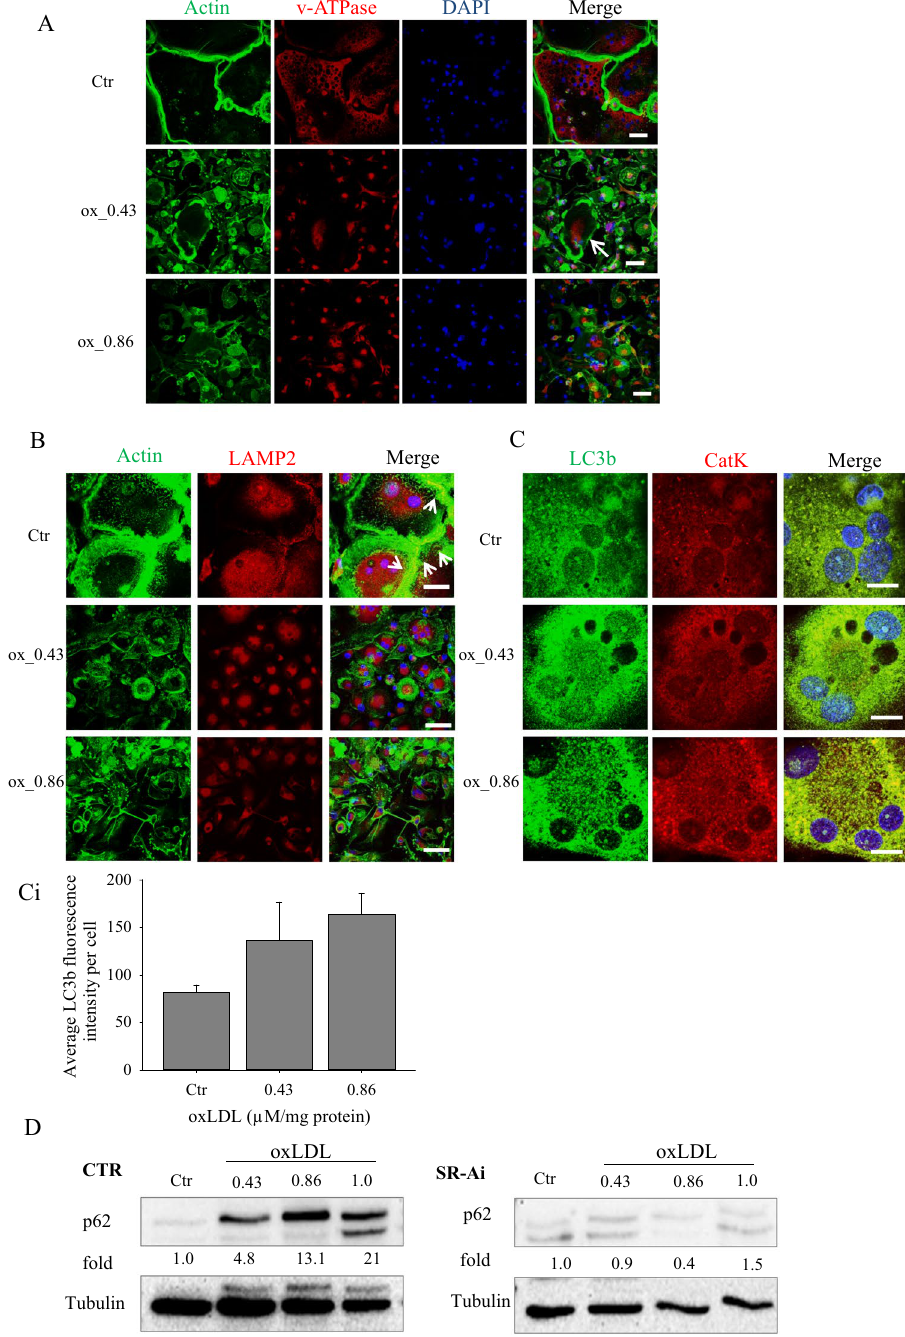
Figure 6. oxLDL inhibits targeting of lysosomal proteins to the ruffled border through autophagy regulation. ( A ) Mature osteoclasts were stained with FITC-phalloidin (green) and co-stained with v-ATPase (subunit a3) (red) Magnification x40, scale bar 50 µ m. White arrows indicate cytoplasmic localization of v-ATPase. ( B ) Mature osteoclasts were stained with FITC-phalloidin (green) and then co-stained with the lysosomal protein; LAMP2 (red) Magnification x63 scale bar 50 µ m. White arrows indicate peripheral localization of LAMP2. ( C ) Monocytes plated on glass coverslips were grown in the presence of M-CSF and RANKL for a total of 15 days. Mature osteoclasts were stained with the lysosomal marker LC3b (in green) and then co-stained with CatK (in red). Magnification x63, zoom 4x, scale bar 15 µ m. Quantification by ImageJ. ( D ) Cells were lysed at day 3 and equal amount of cell lysates were western blotted for